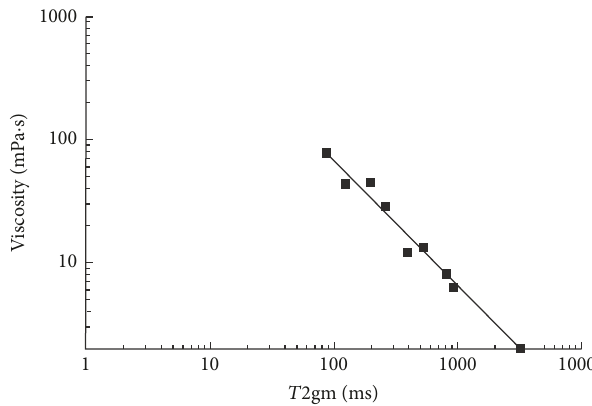
Figure 5: Relationship between fluid viscosity and 𝑇 2 relaxation